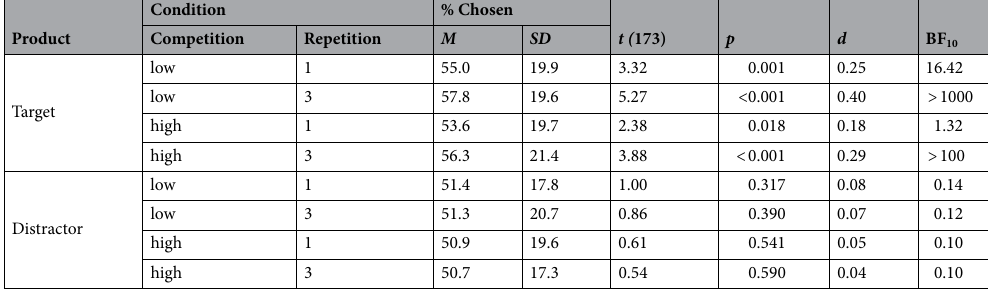
Table 2. Preference choices for target and distractor products (Experiment 1). Results for one-sample t -tests against the expected frequency of choosing randomly during the two-alternative forced-choice tasks (i.e. 50%). Values above 50% indicate a higher preference for target or distractor products compared to novel